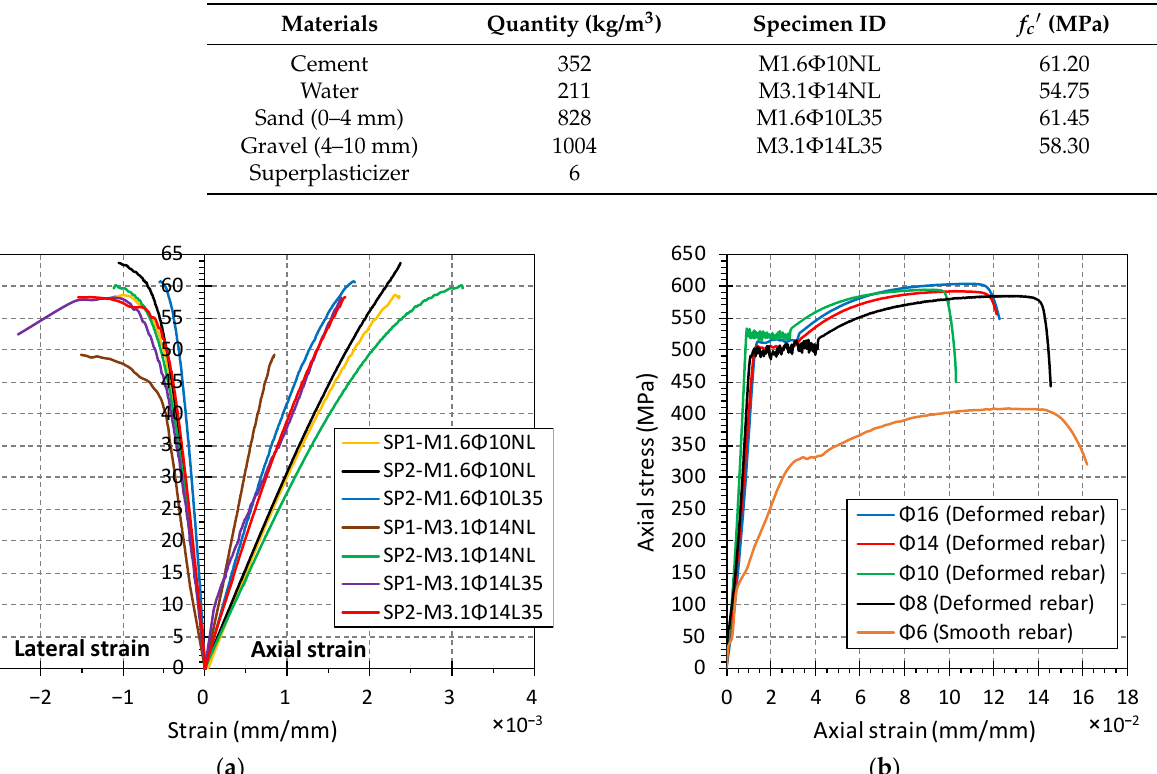
Figure 4. Specimens’ molds and steel reinforcement configuration: ( a ) with continuous longitudi- nal bars; ( b ) with lap-spliced bars.